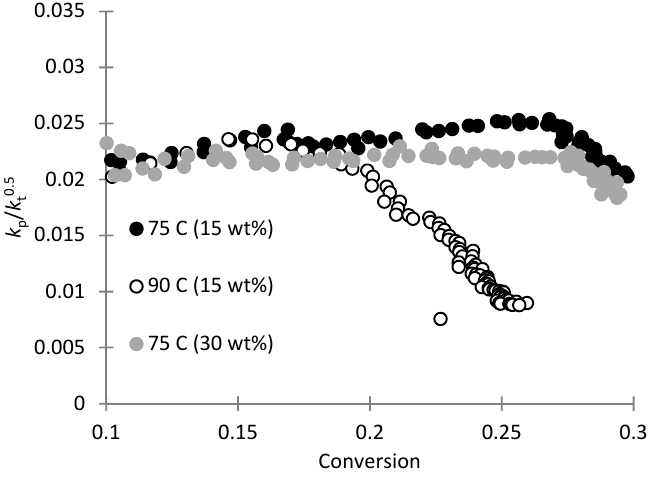
Figure 7. k p / k t0.5 vs. conversion profile of SHMeMB homopolymerization at 75 °C with 15 and 30 wt % monomer concentration and at 90 °C with 15 wt % monomer and 1 wt % V-86 for 15 h.